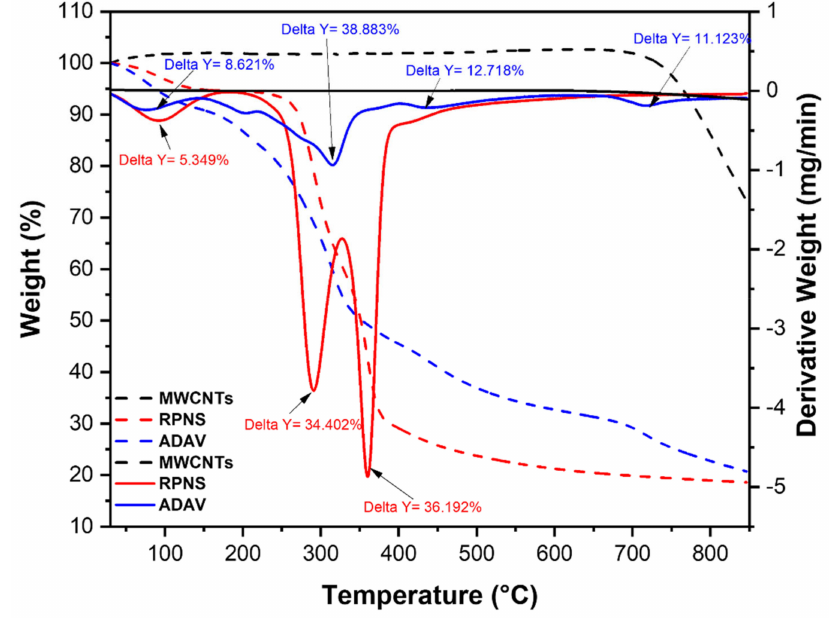
Figure 5. TGA / d TA analysis of RPNS, ADAV, and